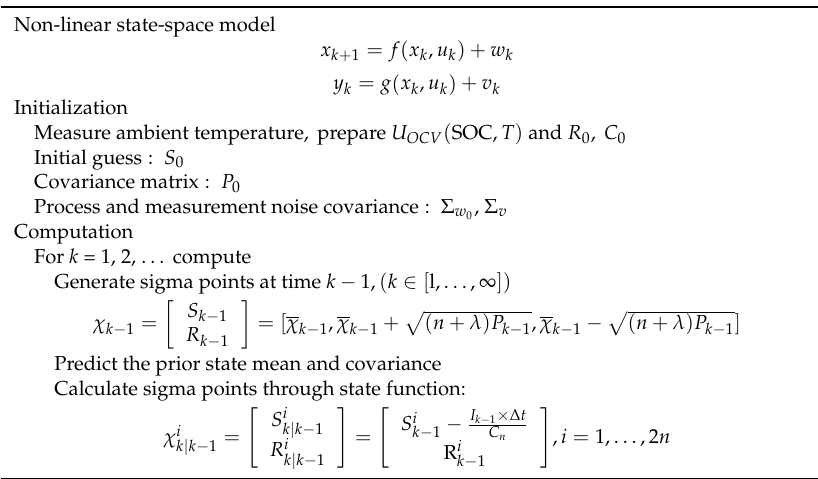
Table 6. Summary of the Unscented Kalman filter approach for SOC estimation